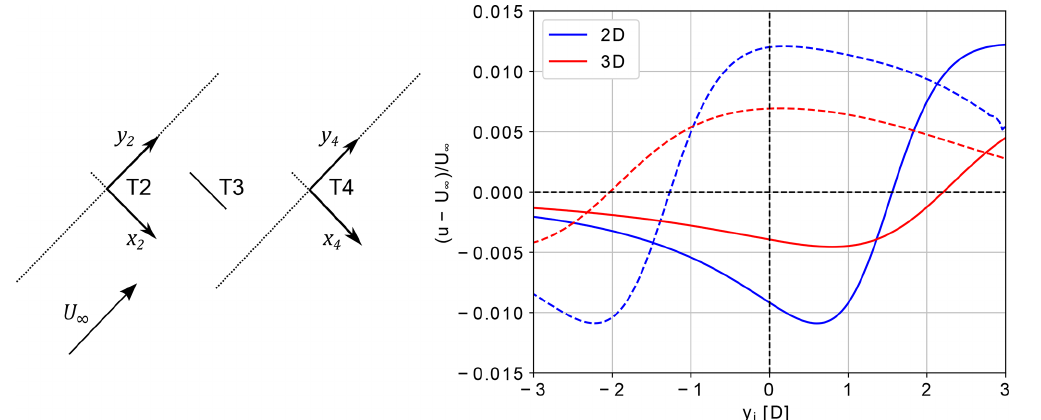
Figure 7. Velocities induced by the central turbine (T3) on the rotor axis of T2 (solid line) and T4 (dashed line), for U ∞ = 7ms − 1 , θ = 45 ◦ and different turbine inter-spacings.